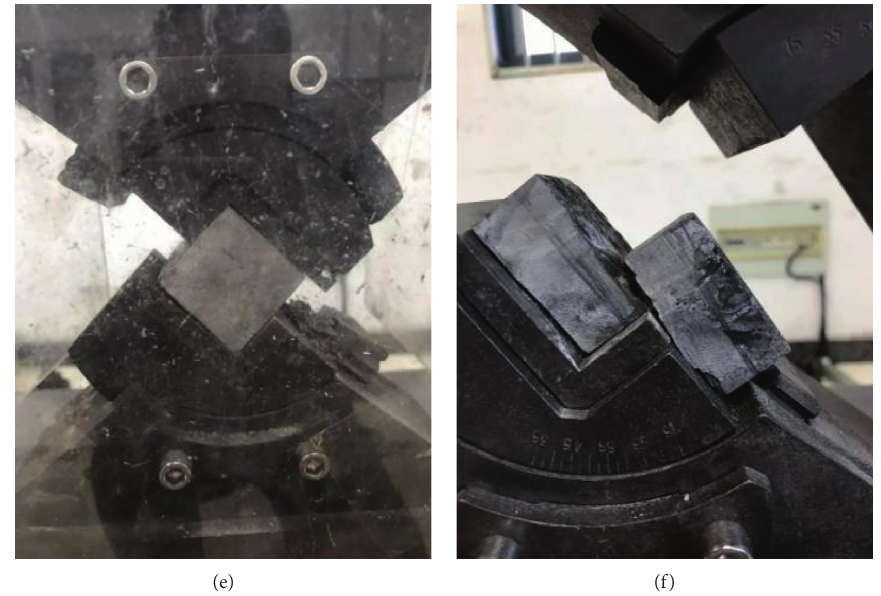
Figure 3: Experimental photos in the laboratory. (a) Before uniaxial compression test. (b) After uniaxial compression test. (c) Before